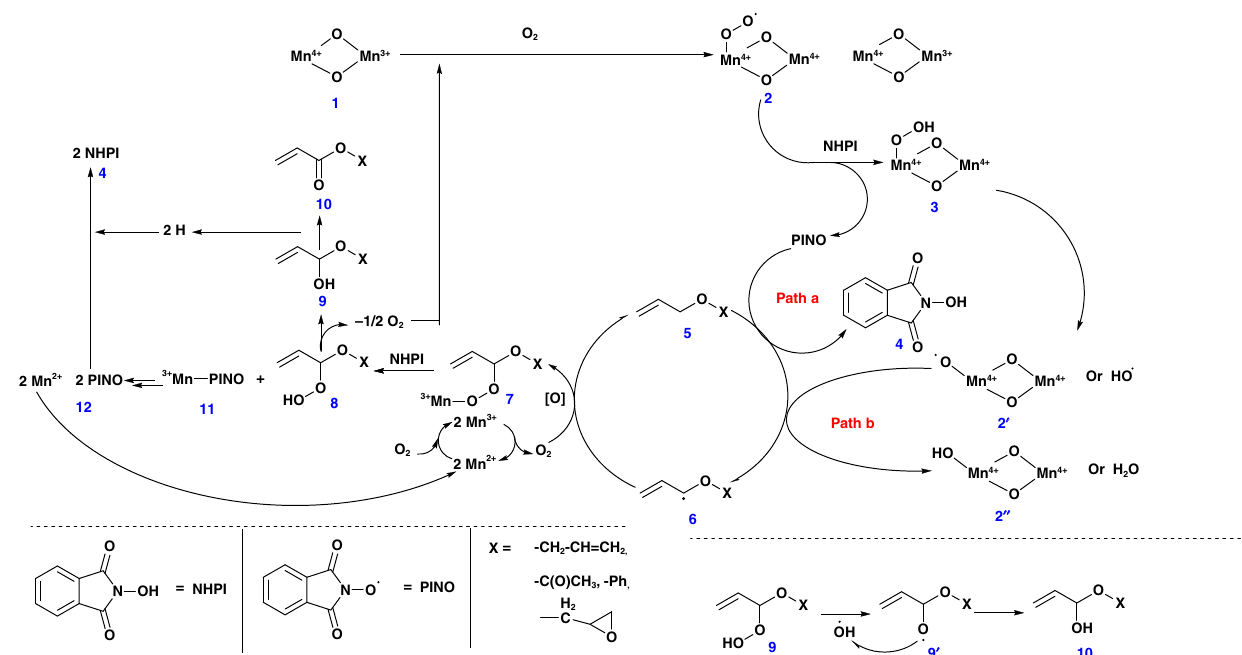
Fig. 2 This fi gure compares earlier mechanisms for acrylate formation using mixed metal oxides, oxygen, and ammonia versus this work using N - hydroxyphthalimide (NHPI), oxygen, and lithium manganese oxides which leads to enhanced (99%) selectivity for all substrates 8 –